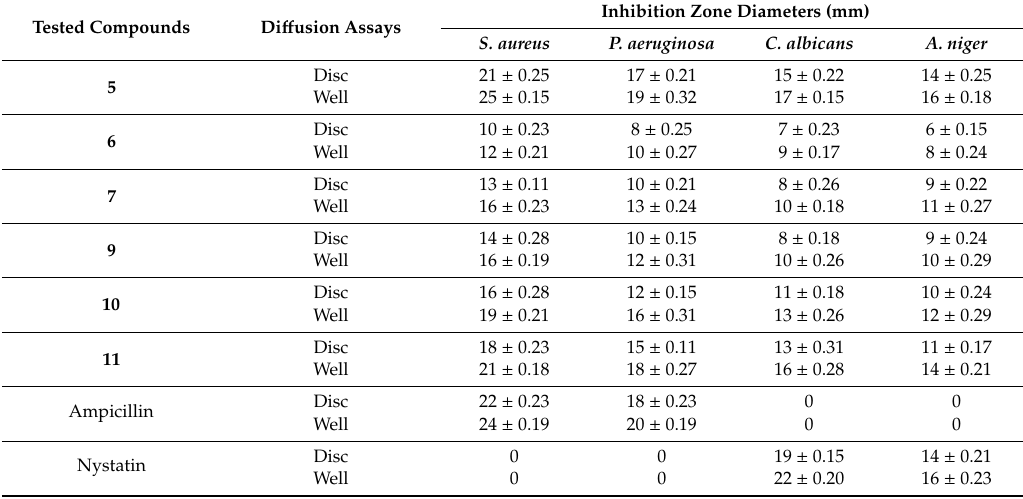
The diameters of the inhibition zone of the tested compounds around tested pathogenic